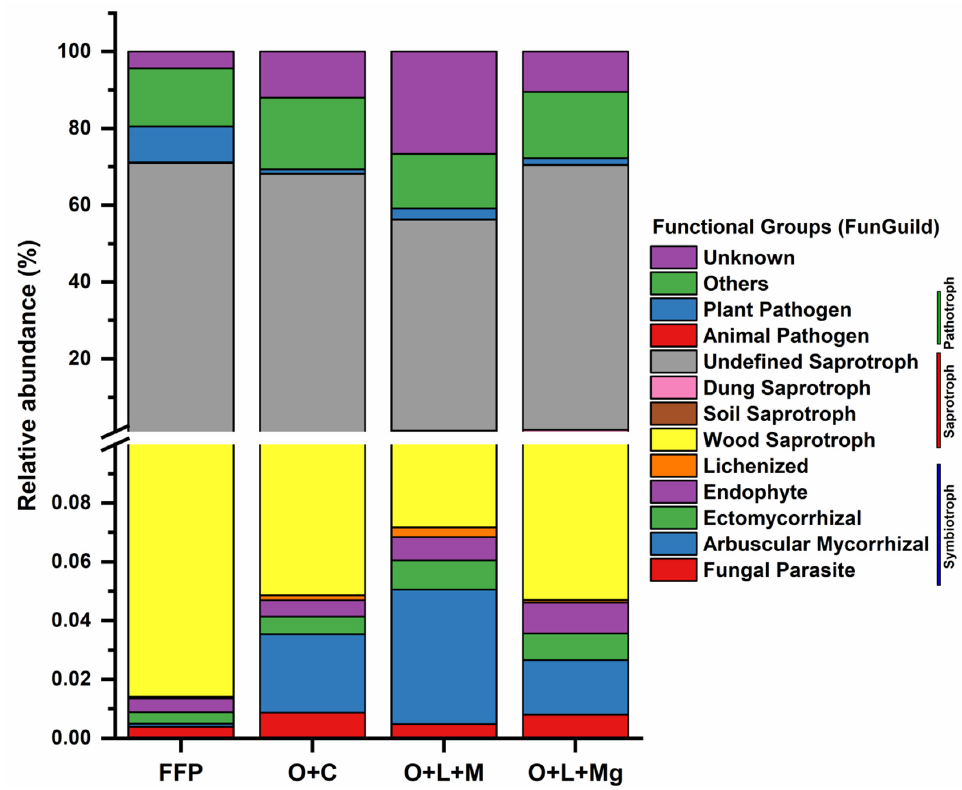
Figure 7. Fungal functional groups inferred by FUNGuild. The variation in the relative abundance of fungal functional groups., i.e., pathotroph, saprotroph, and symbiotroph, was inferred by FUNGuild among different treatments.